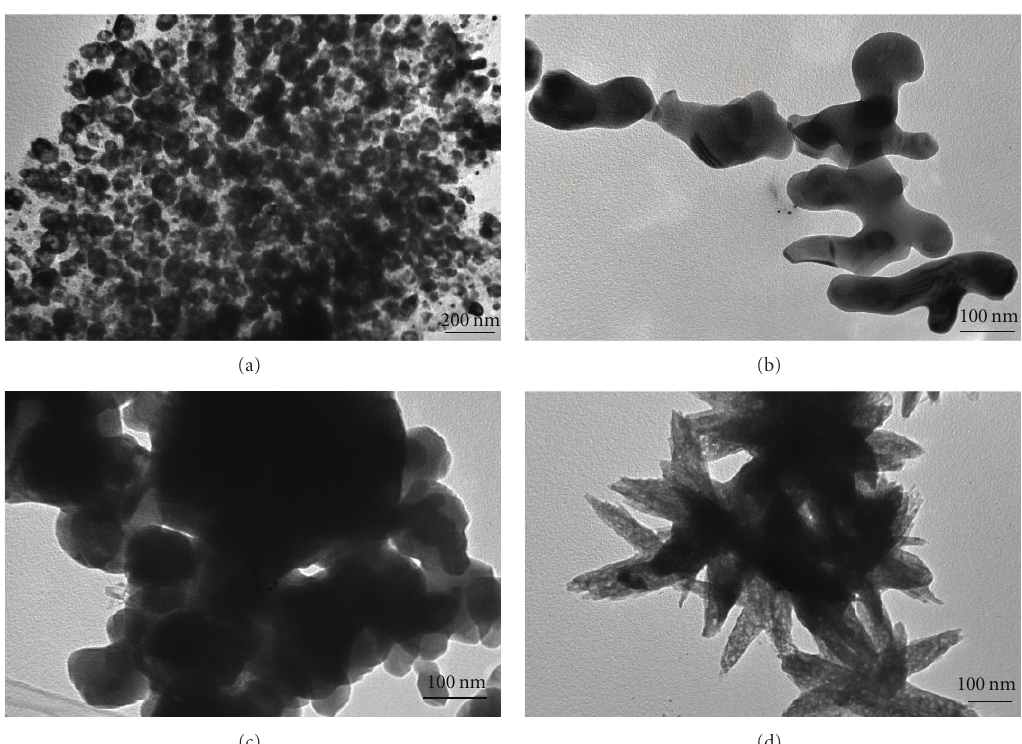
Figure 6: TEM images of iron coated (a) MN-5, (b) MN-6, (c) MN-7, and (d) MN-8 samples.